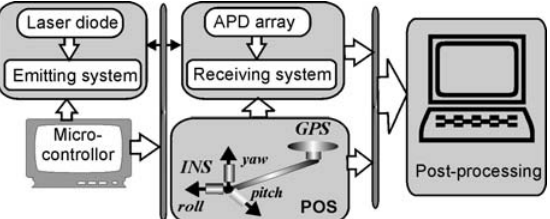
Figure 1. The flowchart of airborne flash LiDAR